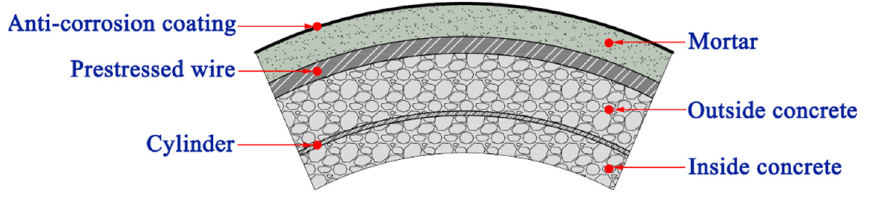
Figure 2. Schematic diagram of structural section composition. Table 1. Geometry and design parameters for tested PCCP.